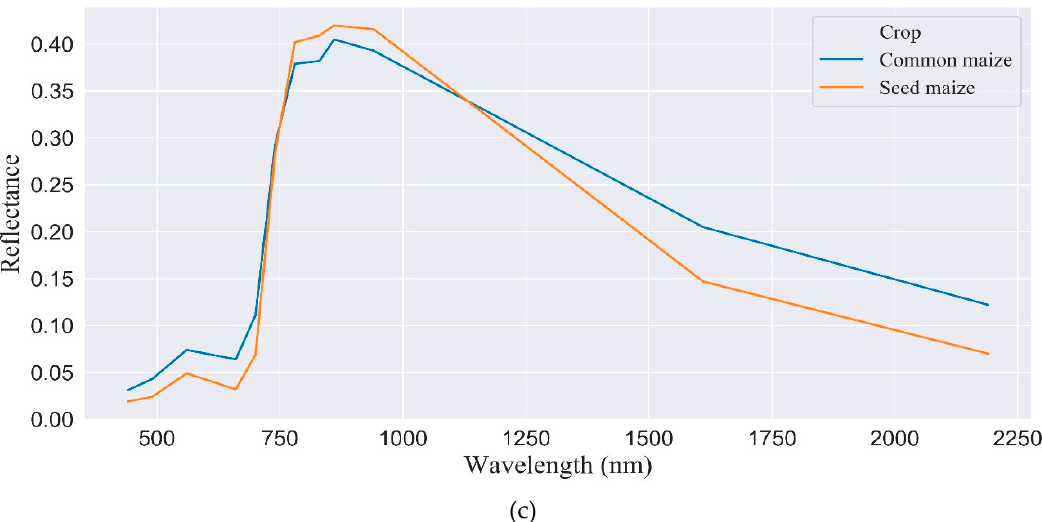
Figure 6. The time series curves and spectral reflectance profiles of seed maize and common maize using Sentinel-2 images. ( a ) NDVI; ( b ) EVI; ( c ) spectral reflectance profiles for seed maize and common maize.